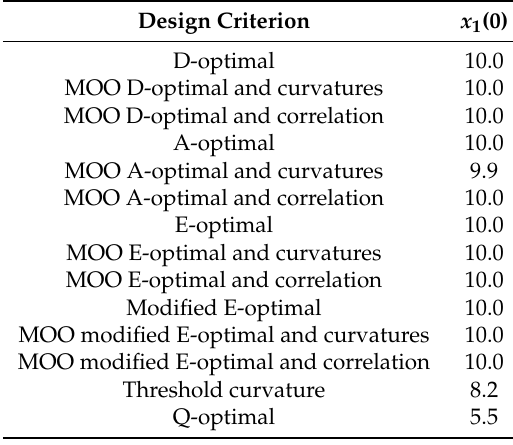
Figure 4. Optimal sampling grid from model-based design of experiments (MBDOEs). Simple Fisher information matrix (FIM)-based criteria shown by continuous line, FIM-based criteria combined with curvatures by dashed line, and FIM-based criteria combined with parameter correlation by dashed-pointed line. Dots indicate the sampling times. Table 2. Optimal initial condition of biomass x 1 ( 0 ) (g/L) from model-based design of experiments (MOO: multi-objective